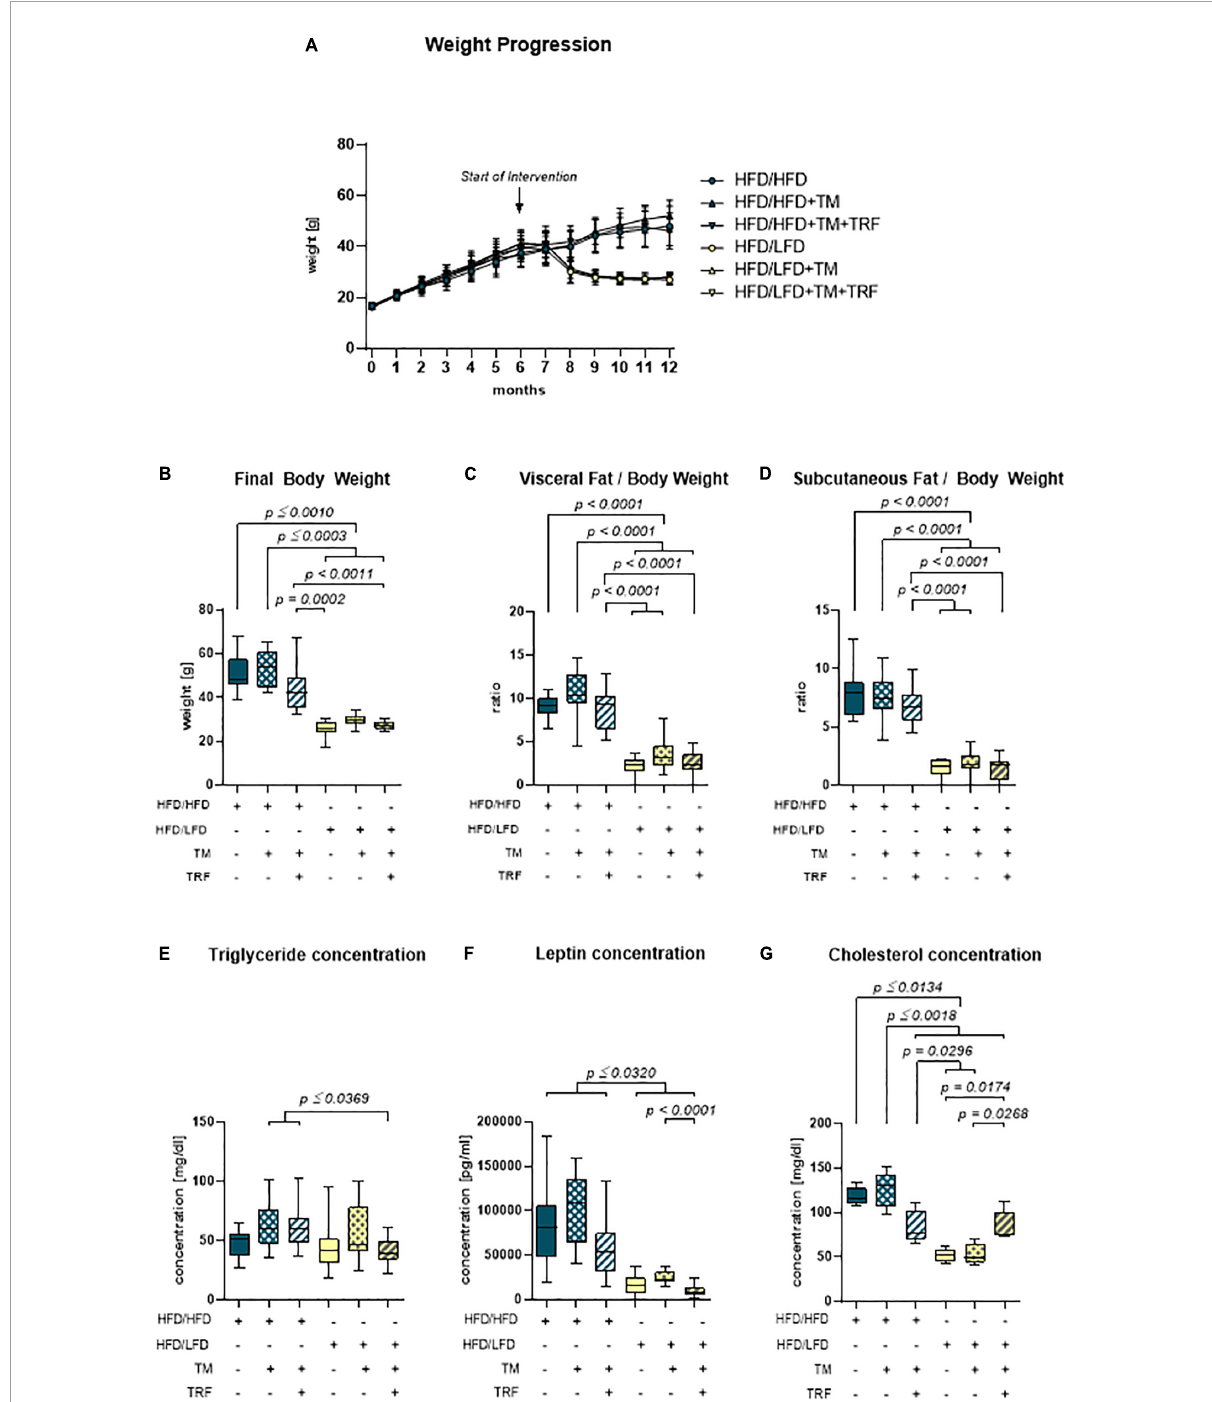
FIGURE2 Body and fat composition. (A) Monthly weight progression with n = 90 mice at the beginning and n = 84 mice at the final time point. (B) Final body weights [g] before euthanasia (HFD/HFD: n = 13, HFD/HFD + TM: n = 13, HFD/HFD + TM + TRF: n = 15, HFD/LFD: n = 14, HFD/LFD + TM: n = 15, HFD/LFD + TM + TRF: n = 13; total n = 83). (C) Ratio of visceral body fat deposits to body weight. (D) Ratio of subcutaneous flanked fat deposits to body weight ( C,D HFD/HFD: n = 13, HFD/HFD + TM: n = 13, HFD/HFD + TM + TRF: n = 15, HFD/LFD: n = 14, HFD/LFD + TM: n = 15, HFD/LFD + TM + TRF: n = 14; total n = 84). All HFD/LFD groups showed a significant fat loss with p < 0.0001 when compared to all three HFD/HFD groups, respectively [ A–D from Power Guerra et al. (28)]. (E) Plasma triglyceride [mg/dL] (HFD/HFD: n = 13, HFD/HFD + TM: n = 13, HFD/HFD + TM + TRF: n = 15, HFD/LFD: n = 14, HFD/LFD + TM: n = 15, HFD/LFD + TM + TRF: n = 14; total n = 84). (F) Plasma leptin [pg/mL] (HFD/HFD: n = 13, HFD/HFD + TM: n = 13, HFD/HFD + TM + TRF: n = 14, HFD/LFD: n = 14, HFD/LFD + TM: n = 15, HFD/LFD + TM + TRF: n = 13; total n = 82) and (G) plasma cholesterol [mg/dL] (HFD/HFD: n = 5, HFD/HFD + TM: n = 5, HFD/HFD + TM + TRF: n = 5, HFD/LFD: n = 5,